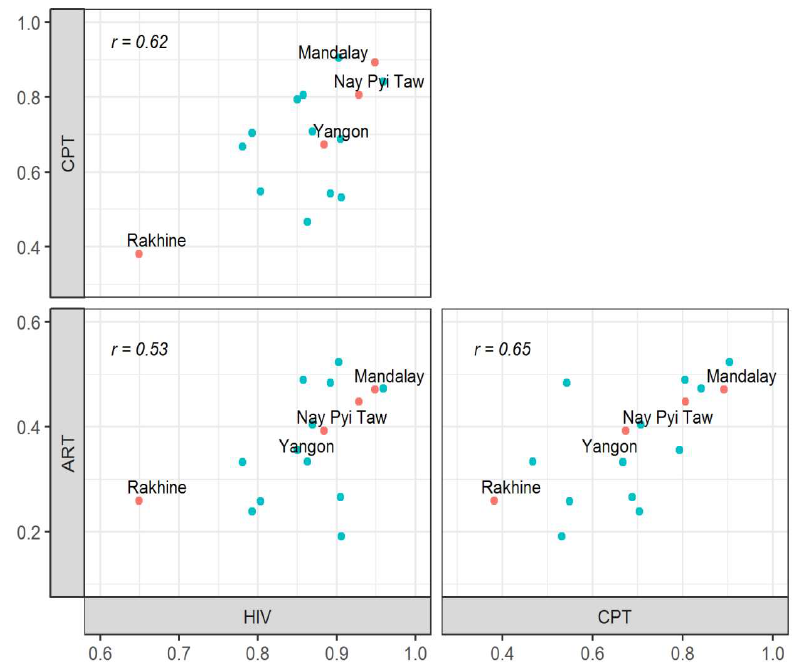
Figure 5. Correlations between the three recommended core performance indicators for TB/HIV services in the 15 states/regions of Myanmar in 2016. Note: Data included only government sector. The highlighted points correspond to regions with low performance (Rakhine) or high development. HIV: TB patients with known HIV status; CPT: HIV-positive TB patients who received CPT; ART: HIV-positive TB patients who received ART; r : Pearson product–moment correlation coefficient.